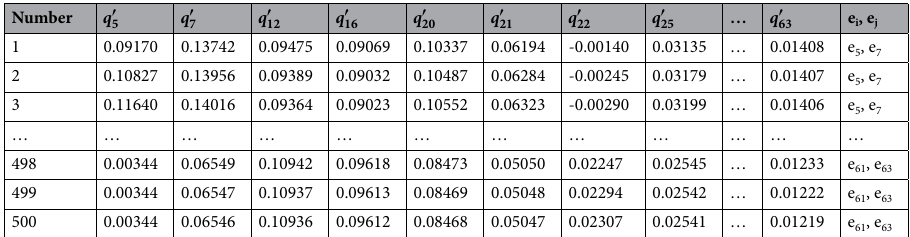
Table 5. Experimental ventilation network multifault sample set.